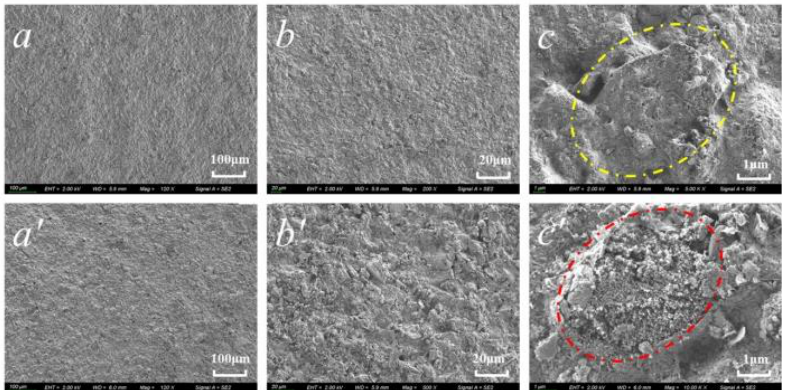
Figure 5. SEM comparison of unmodified activated carbon and 0.0006 mol/cm 3 oxalic acid-modified activated carbon. ( a – c ) shows SEM images of the unmodified activated carbon at 100 μm , 20 μm , and 1 μm , while images ( a ′ ), ( b ′ ), and ( c ′ ) correspond to 0.0006 mol/cm 3 oxalic acid modification at magnifications of 100 μm , 20 μm , and 1 μm SEM images of the activated carbon.